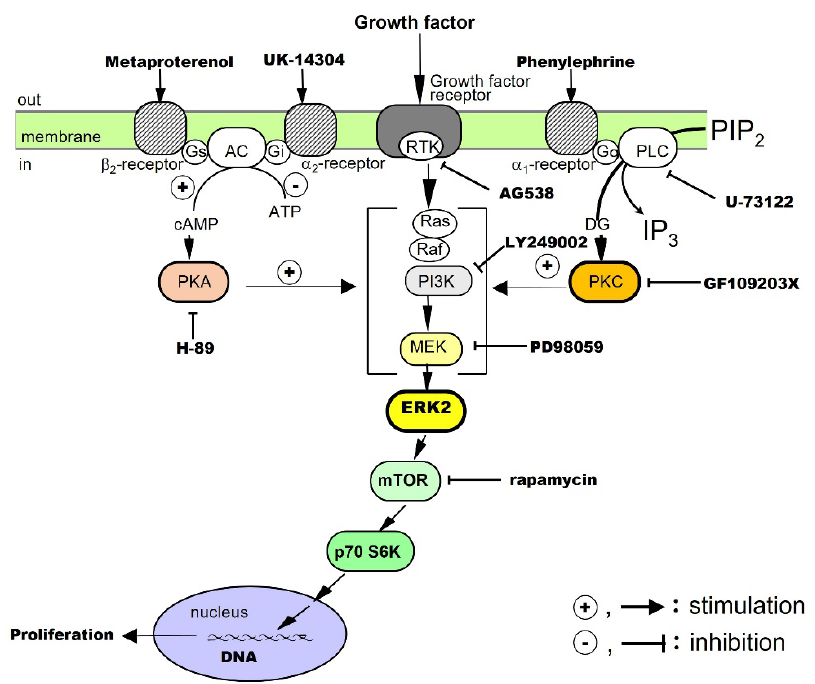
Figure 4. Co-mitogenic effects of α - and β -adrenergic receptor agonists on hepatocyte proliferation stimulated by growth factors.